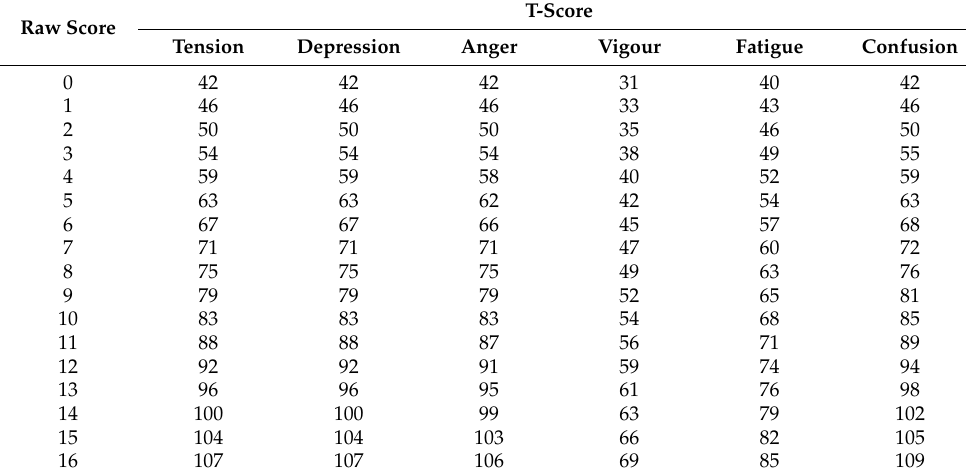
Table 5. MASMS normative scores for the male athlete sample ( n = 1388).